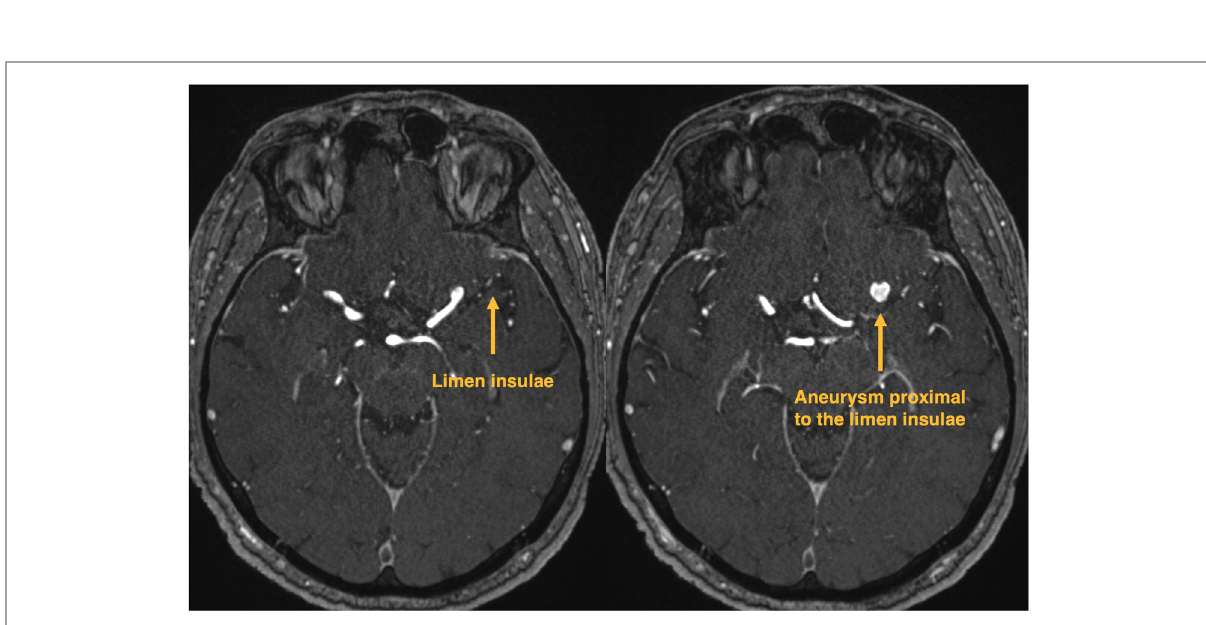
FIGURE 5 Minipterional case. Native time of fl ight angiography MRI with a left-sided MCA aneurysm, located proximally to the limen